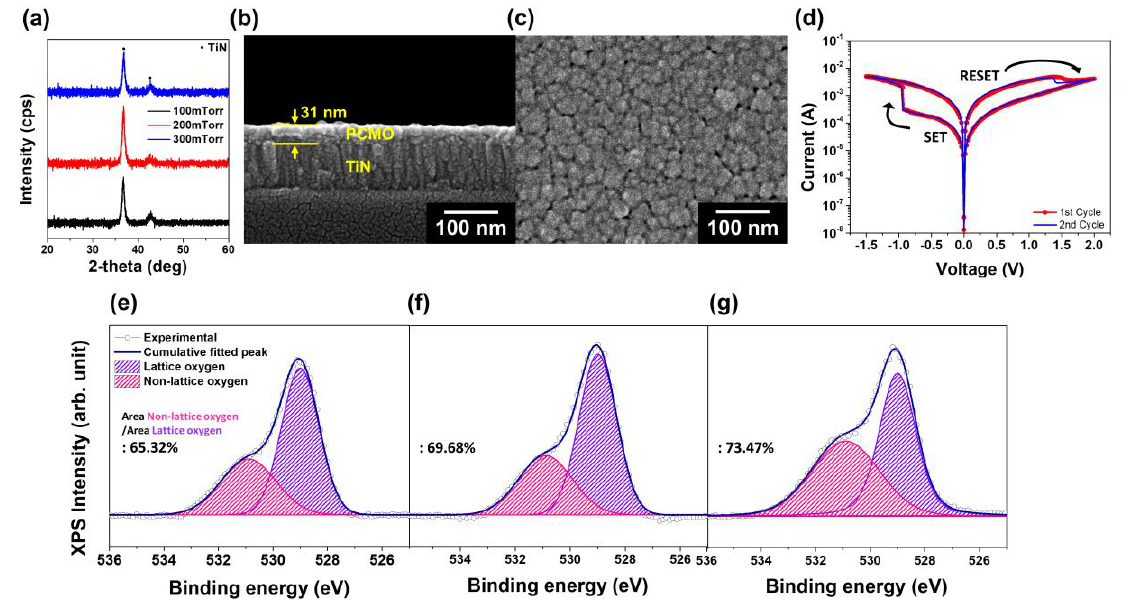
Figure 1. ( a ) XRD patterns of the PCMO thin films deposited on the TiN – Si substrate at 300 °C by varying the OP. SEM images of the ( b ) cross-section and ( c ) surface of the PCMO thin film deposited at 100 mTorr OP. ( d ) I – V curve of the PCMO thin film deposited at 100 mTorr OP. XPS O1s spectra of the PCMO films grown by varying the OP: ( e ) 300 mTorr, ( f ) 200 mTorr, and ( g ) 100 mTorr.